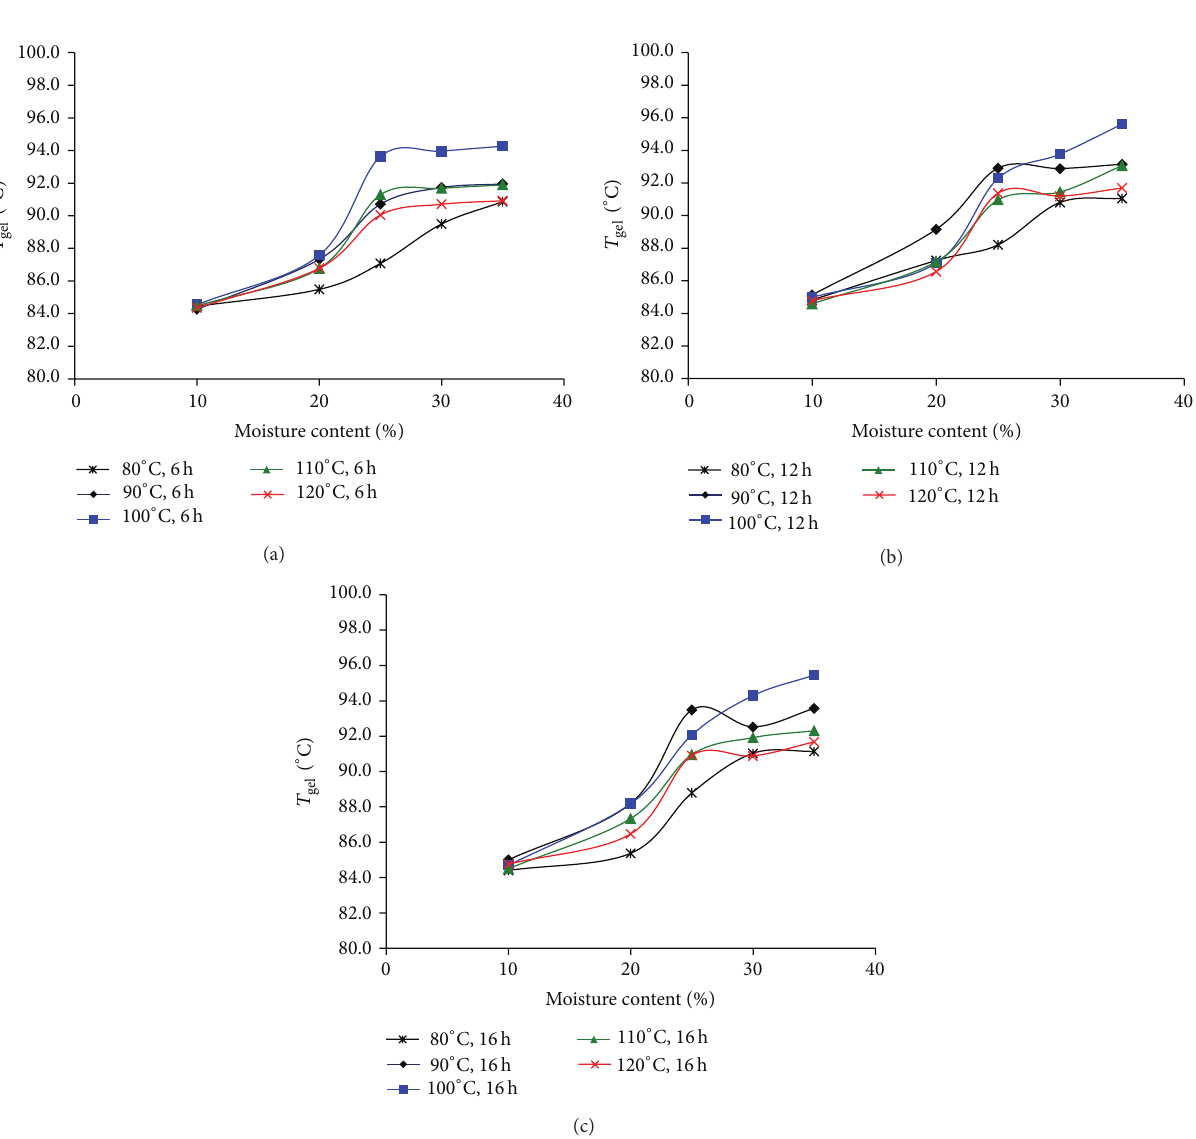
Figure 5: Gelatinization temperatures of HMT-JFS samples prepared under varied conditions of moisture contents (10–35%), temperatures (80–120 ∘ C), and times (6, 12, and 16